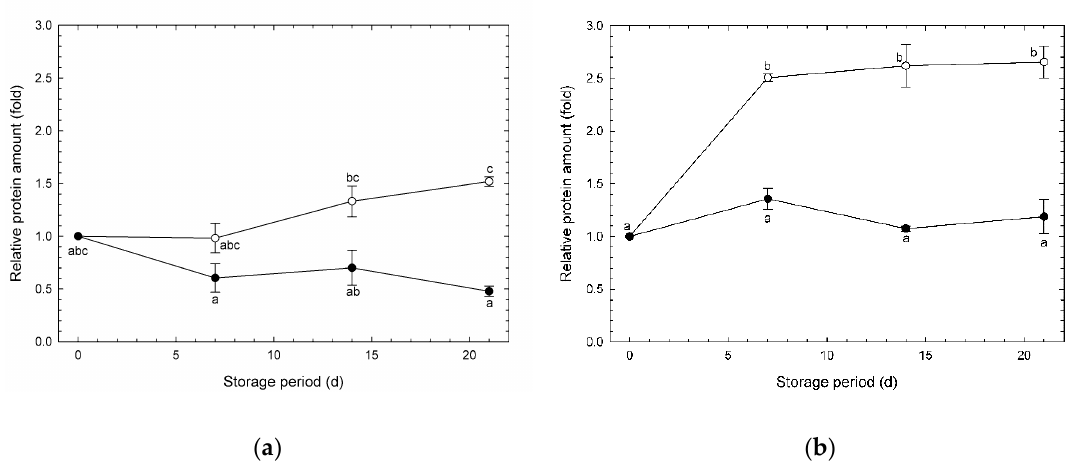
Figure 5. Relative amount of alternative oxidase (AOX) in broccoli heads during storage at 1 °C. ( a ) Experiment #1: , normoxia; , O 2 /CO 2 = 2.5%/6.0% (+ N 2 to 100%). ( b ) Experiment #2: , normoxia; , O 2 /CO 2 = 2.5%/0.0% (+ N 2 to 100%). Values are means ± SE of three biological replicates. Significant differences ( p < 0.05) are denoted by different letters.